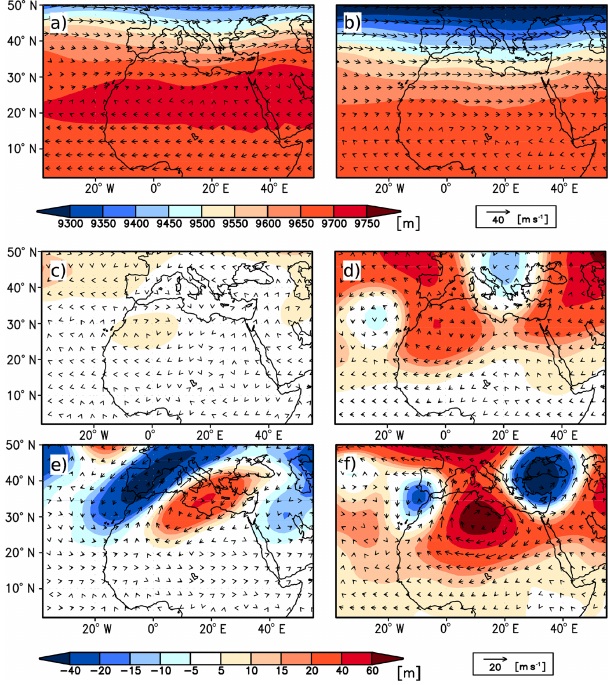
Figure A1. Monthly mean geopotential height at 300hPa (m, shaded) and wind at 300hPa (ms − 1 , vector) for (a) 7ka Septem- ber and (b) 7ka October. (c, d) Differences in 300hPa geopoten- tial height (m, shaded) and 300hPa wind (ms − 1 , vector) between the composite of all rain events occurring in the coastal area (15– 11 ◦ W, 20–25 ◦ N) and the monthly mean flow for (c) 7ka Septem- ber, (d) 7ka October; (e, f) differences between the composite of all rain events in the western Sahara (20–35 ◦ N, 10 ◦ W–10 ◦ E) and the monthly mean flow for (e) 7ka September and (f) 7ka October. The months have been adjusted to the fixed-angular